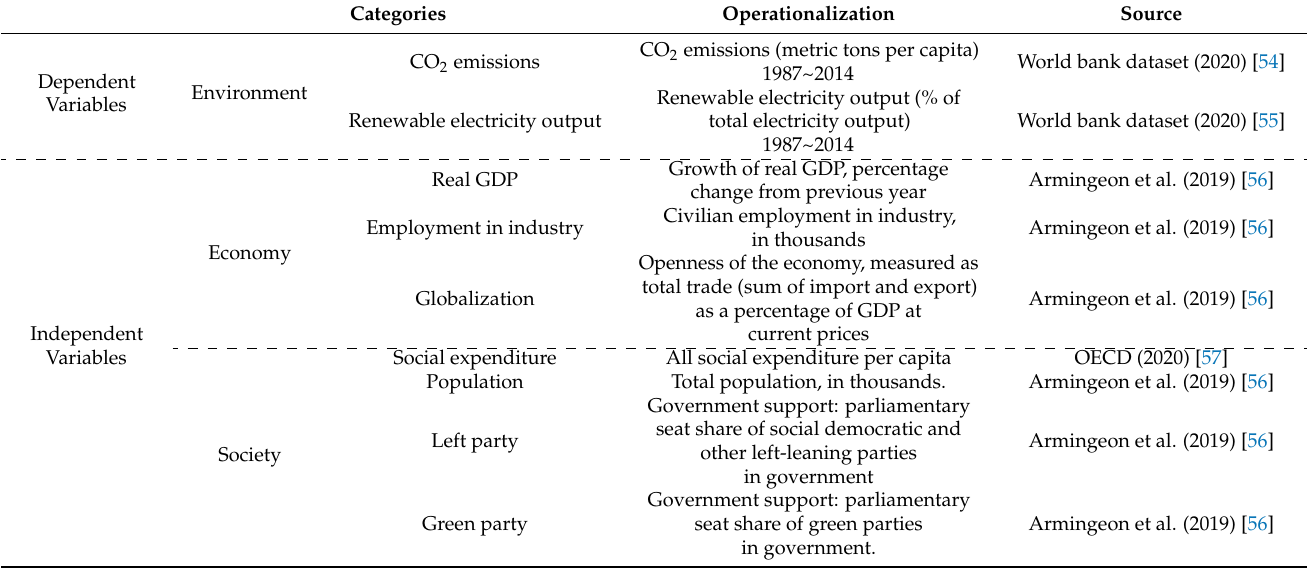
Table 1. The Variable